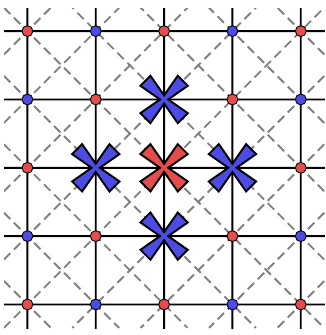
[ i.e. the t (cid:48) term in H from t (cid:48) t (cid:48) - J z - V 0